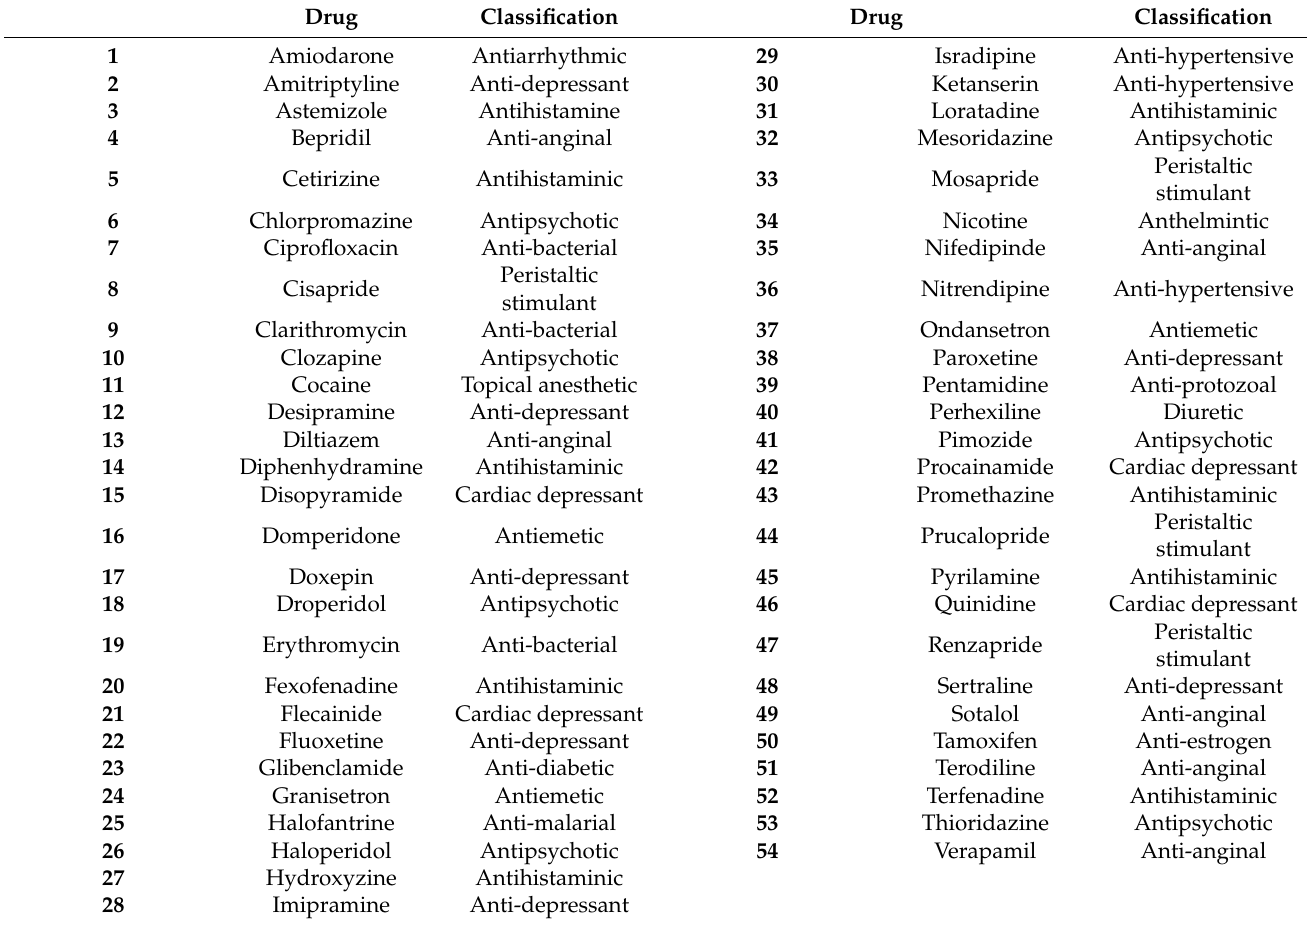
Table 1. Compounds that may prolong QT and/or induce Torsades de Pointes .